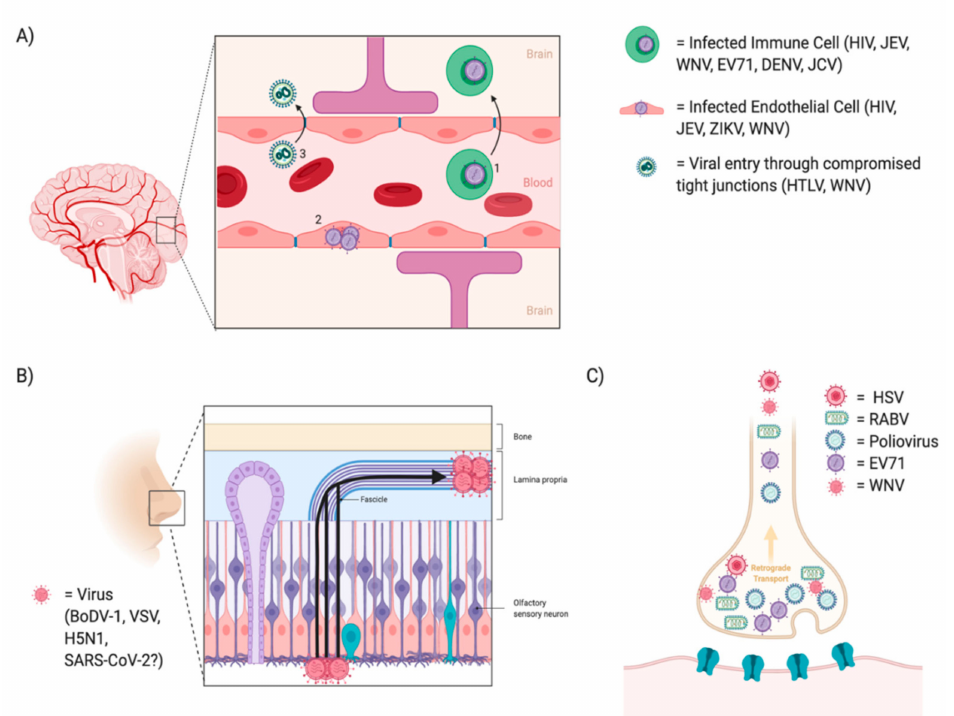
Figure 7. Mechanisms of viral entry into the central nervous system. ( A ) Viral entry through the BBB can occur via 3 methods: (1) The Trojan Horse model where a virus leverages a permissive host immune cells as a vehicle, (2) direct infection of brain microvascular endothelial cells (BMVECs) and (3) viral entry through dysregulation of tight junction proteins. ( B ) Viral entry through the nasal epithelium occurs through infection of the peripherally located olfactory receptors neurons and into the lamina propria which ultimately terminates in the olfactory bulb. ( C ) Infection through peripheral nerves allows for viruses to move in a retrograde manner towards multiple brain centers. HIV: Human immunodeficiency virus; JEV: Japanese encephalitis virus; WNV: West Nile virus; EV71: Enterovirus A71; DENV: Dengue virus; ZIKV: Zika virus; HTLV: Human T Lymphotropic